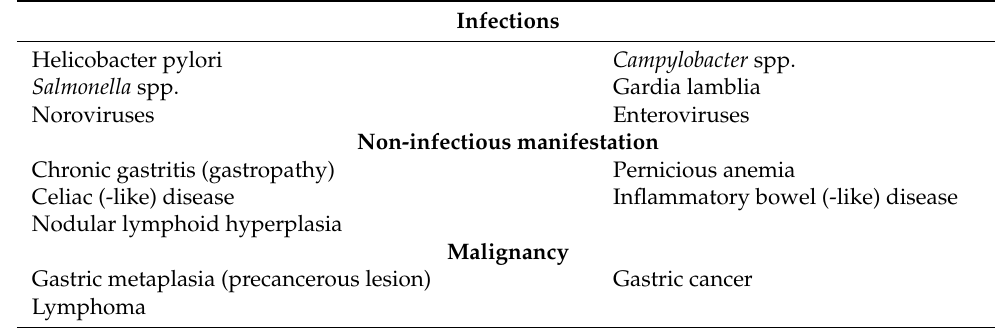
Table 1. Summary of the most common infectious, non-infectious and malignant complications associated with Primary antibody